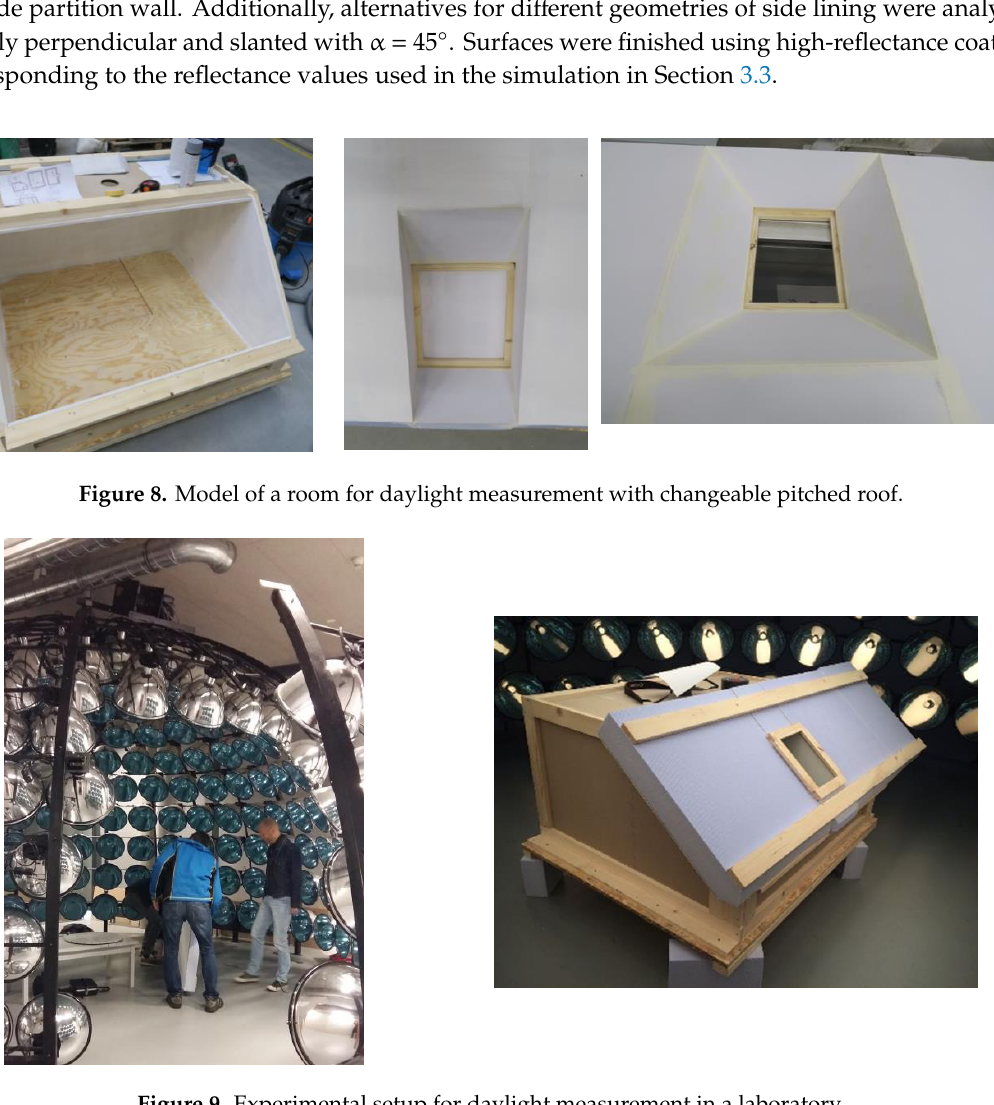
Figure 9. Experimental setup for daylight measurement in a laboratory.